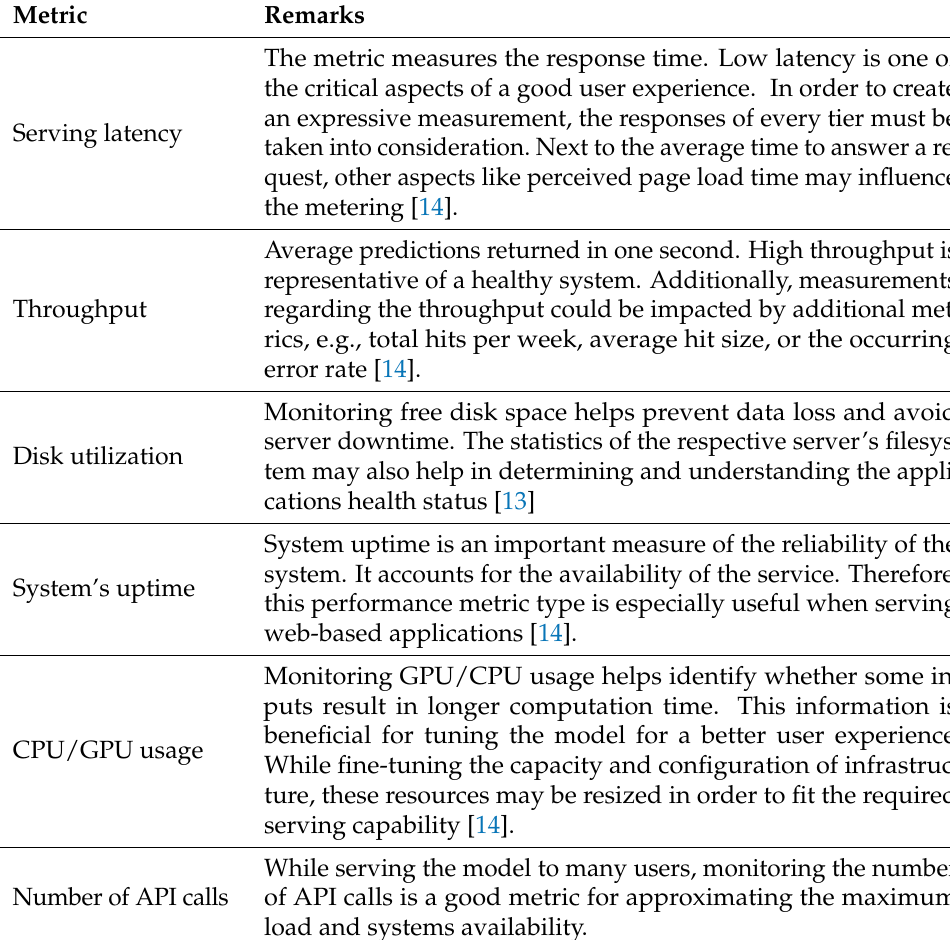
Table 2. Metrics for system